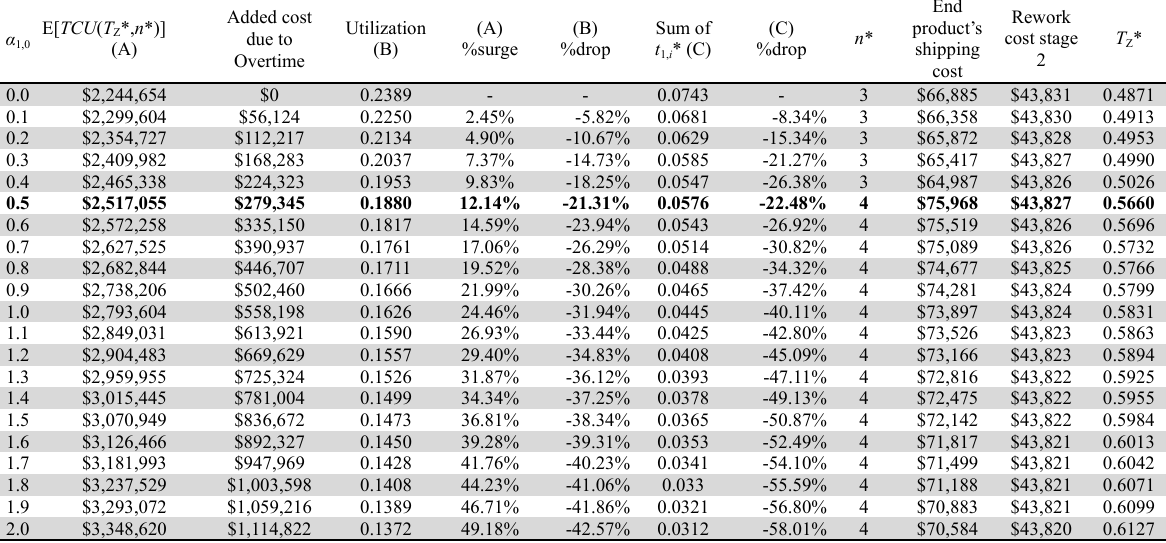
Different critical system features influenced by overtime factor α